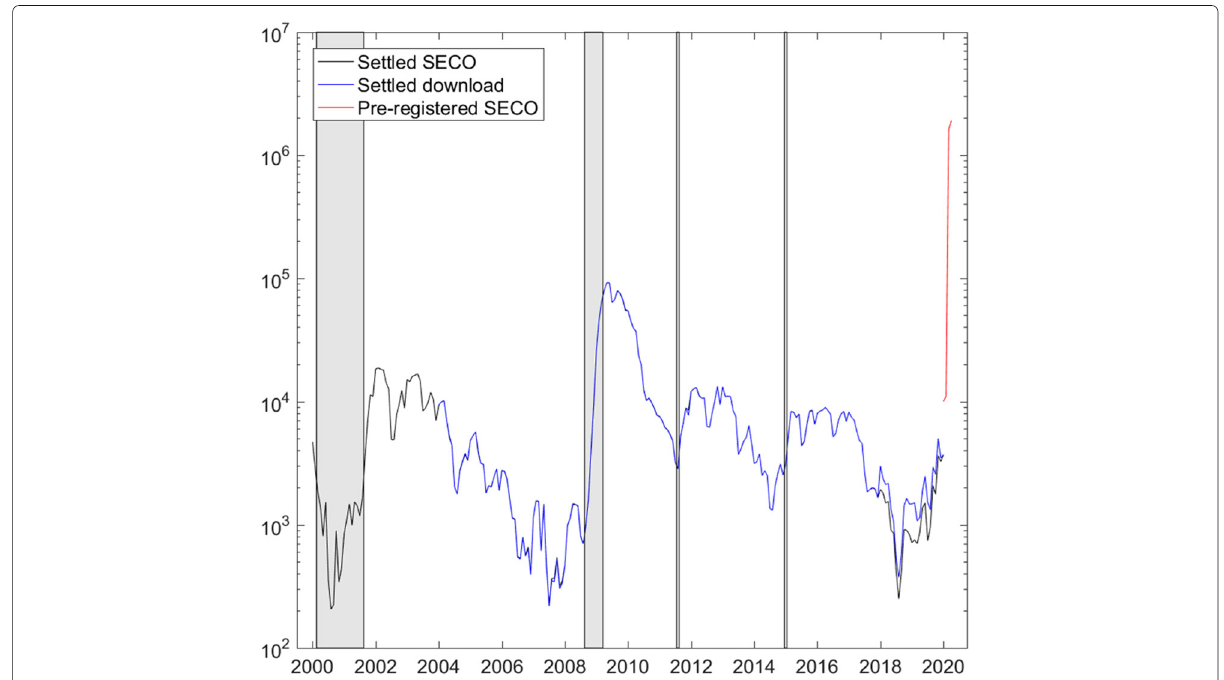
Fig. 1 Short-time workers. Monthly frequency, logarithmic scale. Gray bars highlight the dotcom and financial crises, the introduction, and discontinuation of the euro-Swiss franc floor. Settled SECO: published pdf-file (https://www.seco.admin.ch/seco/de/home/Arbeit/ Arbeitslosenversicherung/leistungen/kurzarbeitsentschaedigung.html) as of May 1, 2020, January 2000–January 2020; Settled download: Download (https://www.amstat.ch/v2/index.jsp) as of May 2, 2020, January 2004–January 2020; pre-registered SECO: obtained by e-mail as of May 1,